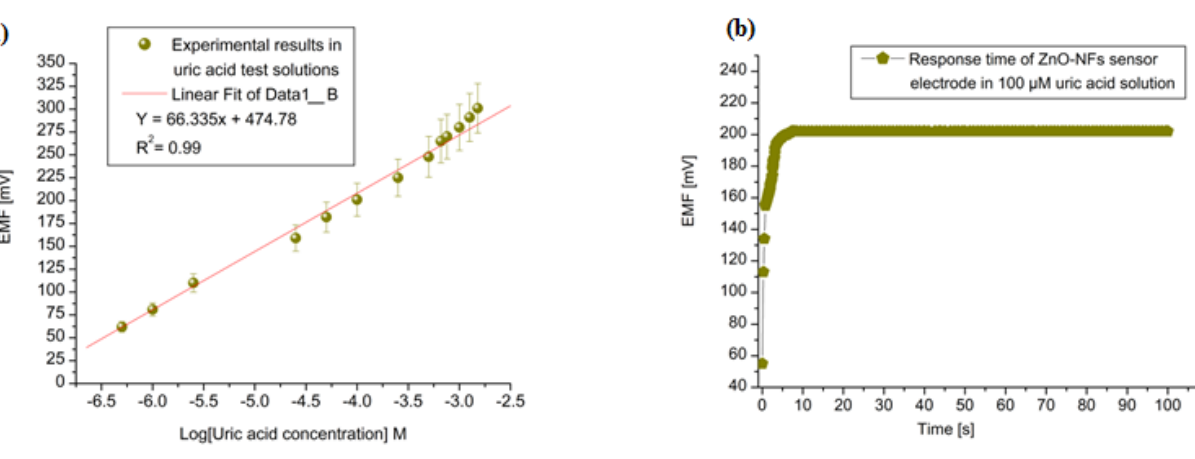
Figure 4. ( a ) Calibration curve for the ZnO-NFs based uric acid sensor and ( b ) Time response of the ZnO-NFs based uric acid sensor in 100 µM uric acid